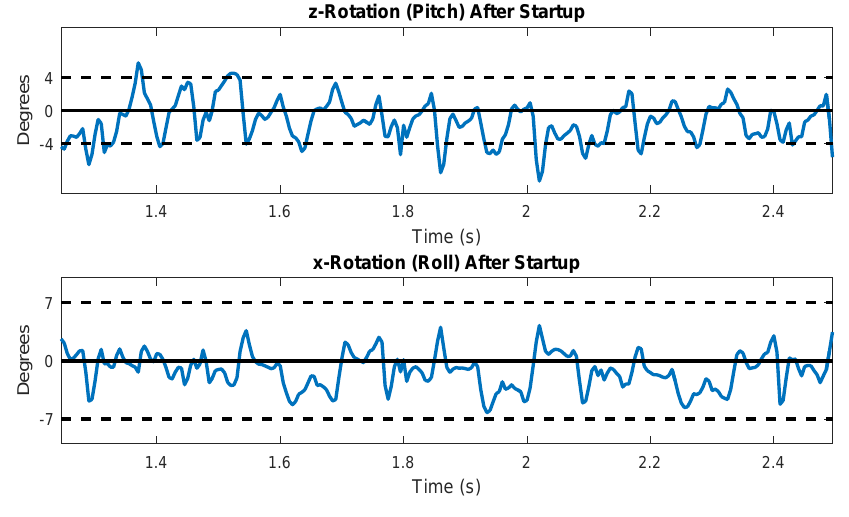
Figure 11. Pitch and roll of the body during steady state walking.